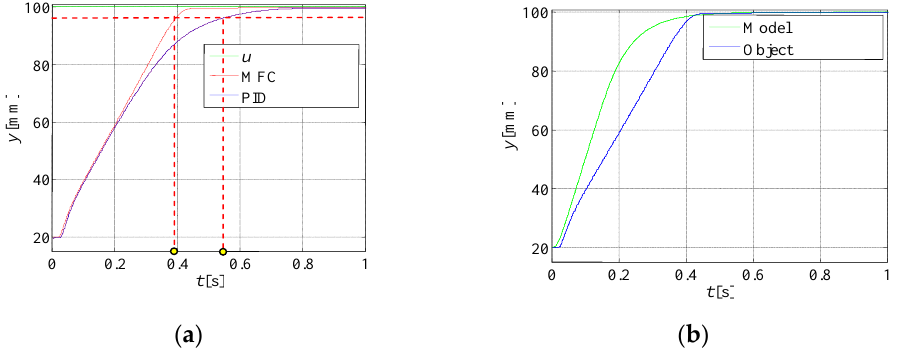
Figure 16. ( a ) Comparison of MFC i PID controller (red line — set link time); ( b ) piston rod dis- placement for MFC regulator and EHSD model in main controller loop ( p 0 = 12 MPa, F L = 1800 N).